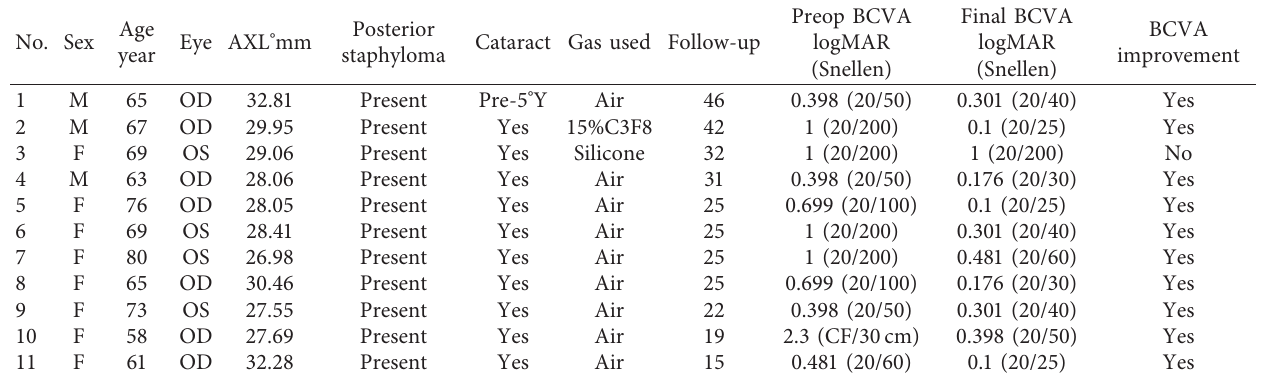
Table 1: Basic characteristics of patients ( n � 11) with highly myopic foveoschisis-associated lamellar macular